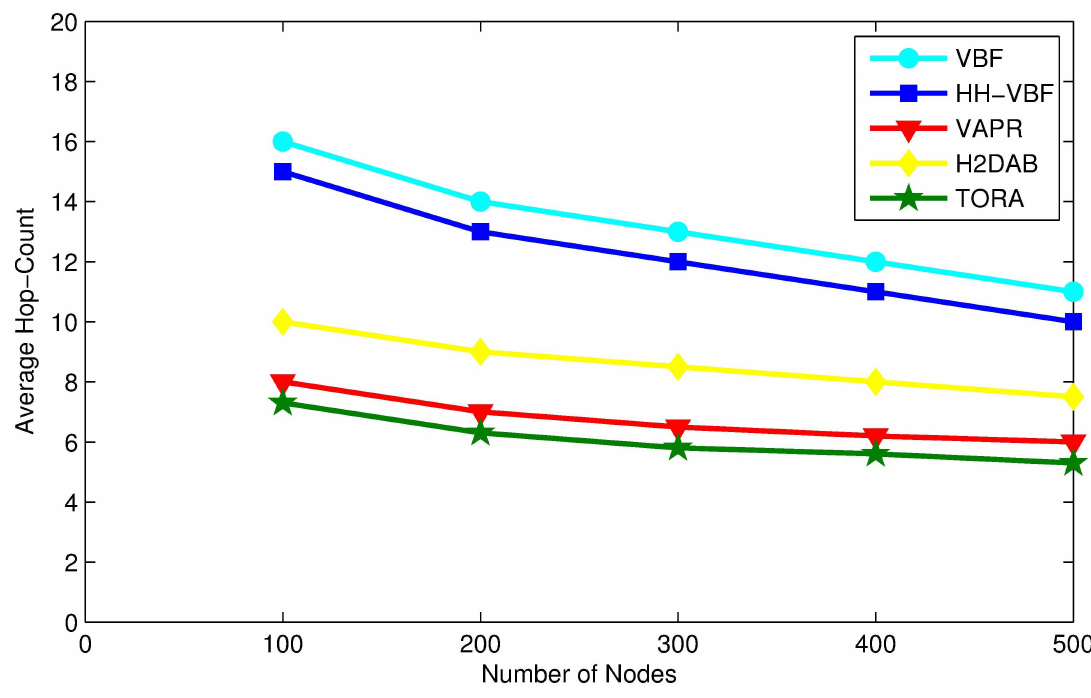
Fig 11. Average hop-count vs. node